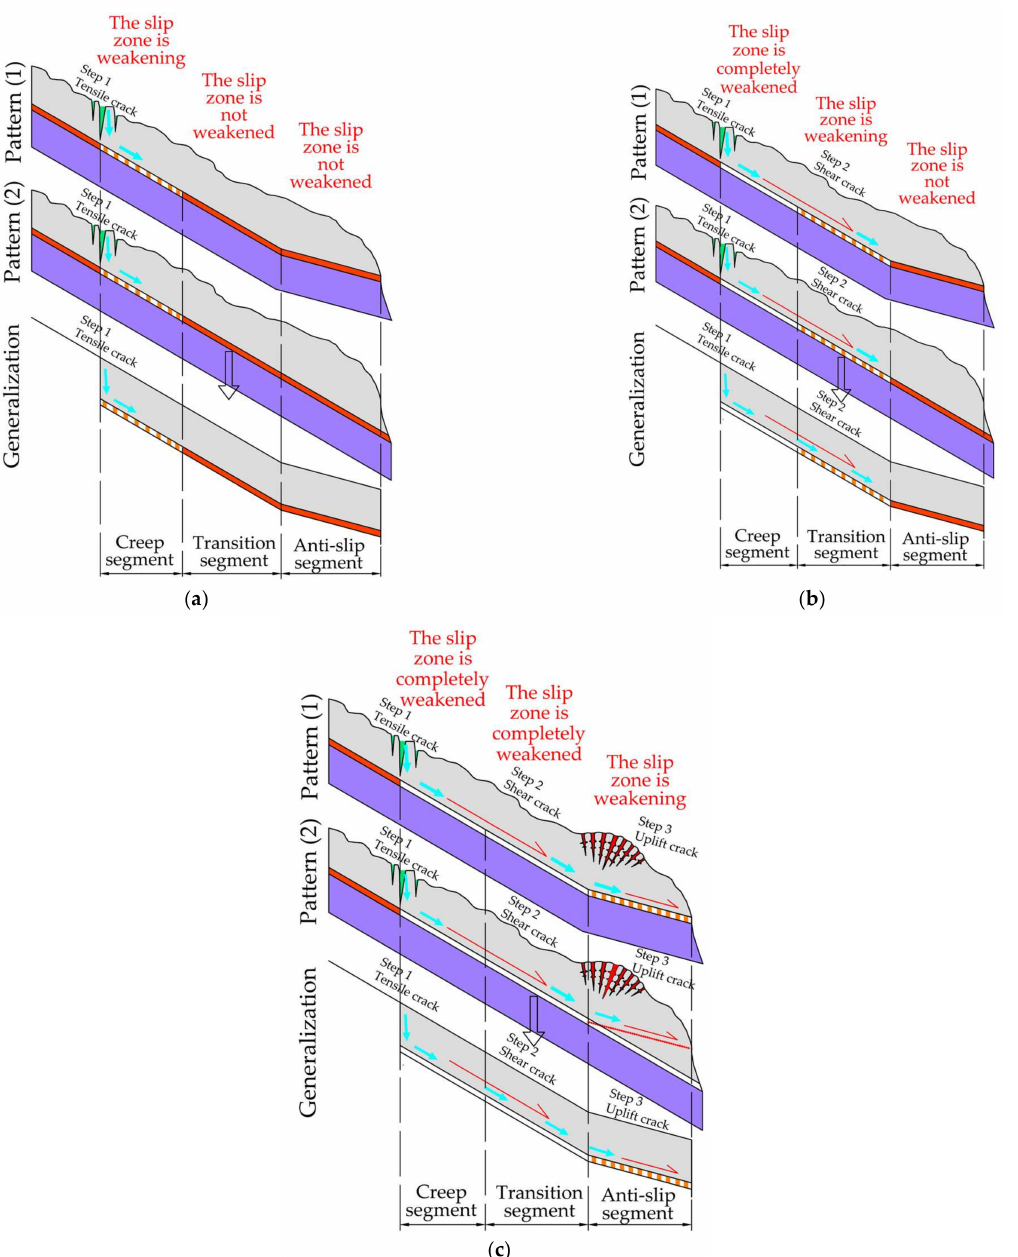
Figure 2. Two patterns and generalized models of thrust-load-induced accumulation landslides [44]: ( a ) step 1; ( b ) step 2; ( c ) step